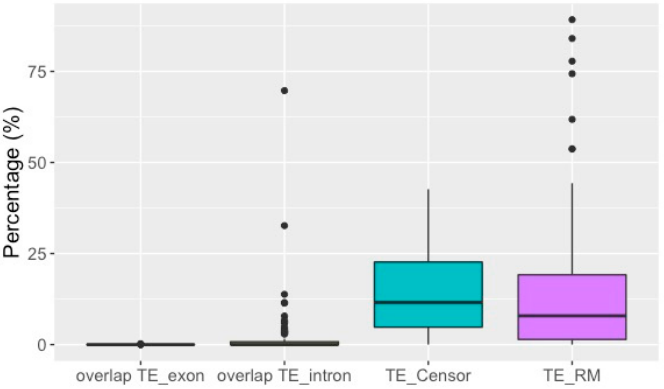
Figure 4 . Box plots of TE abundance and overlap of TEs with exons and introns in fosmid data. TEs were identified with Censor from translated fosmid DNA sequences. All frequencies were calculated as % of total fosmid lengths. Boxes contain the interquartile range from the 25th to the 75th percentile, the horizontal line indicates the median, and vertical lines indicate minimum and maximum distributions of the data. Outliers are shown by dots.